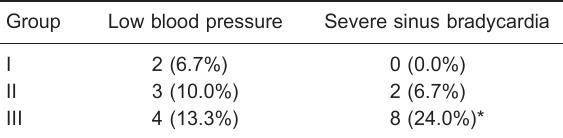
Data are reported as number and percent for n=30 patients/group. GroupI:10 mLisotonicsaline;groupII: 0.5 m g/kgdexmedetomidine (DEX) in 10 mL isotonic saline; group III: 1.0 m g/kg DEX in 10 mL isotonic saline. *P , 0.05, group III vs groups I and II (Fisher’s exact